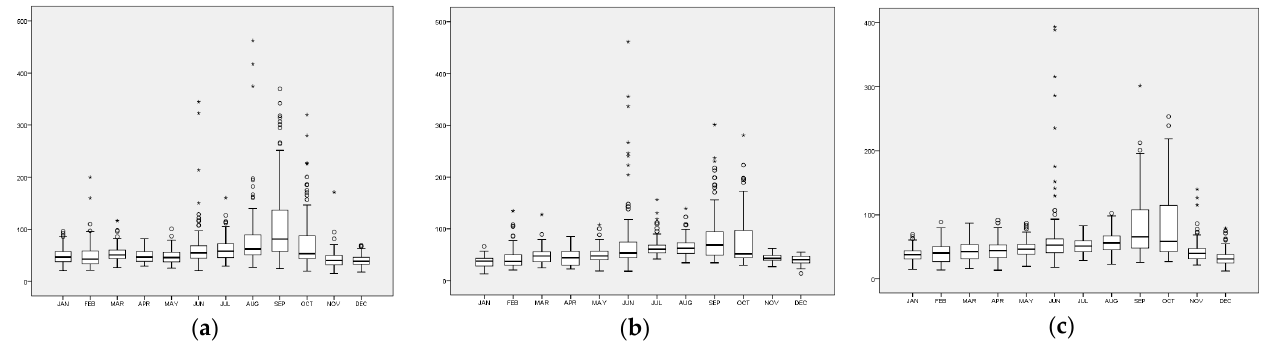
Figure 3. Monthly average boxplot of PM10 level in ( a ) Petaling Jaya, ( b ) Melaka, and ( c ) Pasir